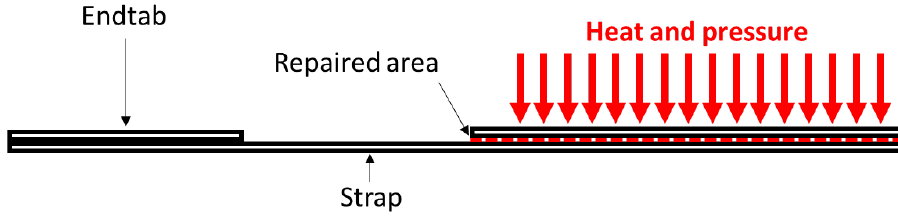
Figure 31. Schematic of lap strap repair.